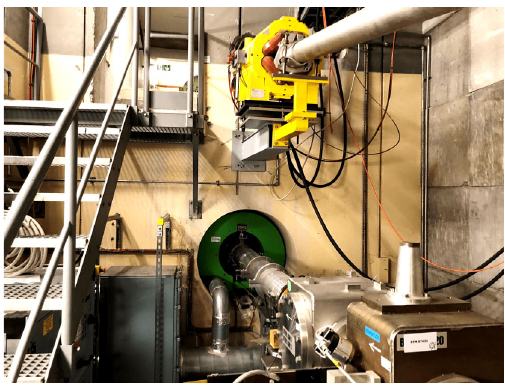
FIG. 8. View of the entrance of the beam dump cavity at the end of the BTM cavity in November 2019. Visible on the left side in the foreground under the staircase to ISOLDE, the Air Handling Unit (AHU) and the cooling ducts feeding into the